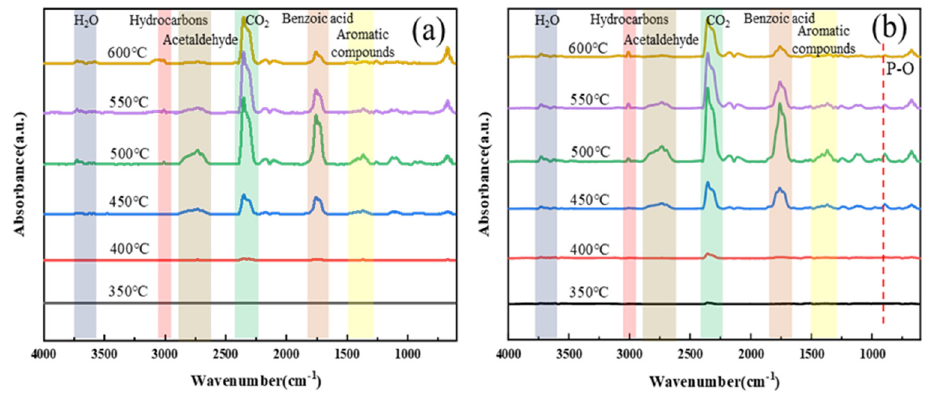
Figure 7. FTIR spectra of pyrolysis gases at different temperature for ( a ) PET and ( b ) 20 wt%hbDT/PET in TG-IR tests.